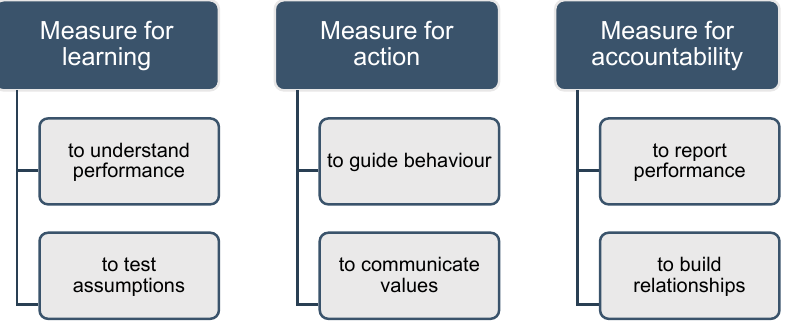
Figure 1. Purposes of Measurement [46].